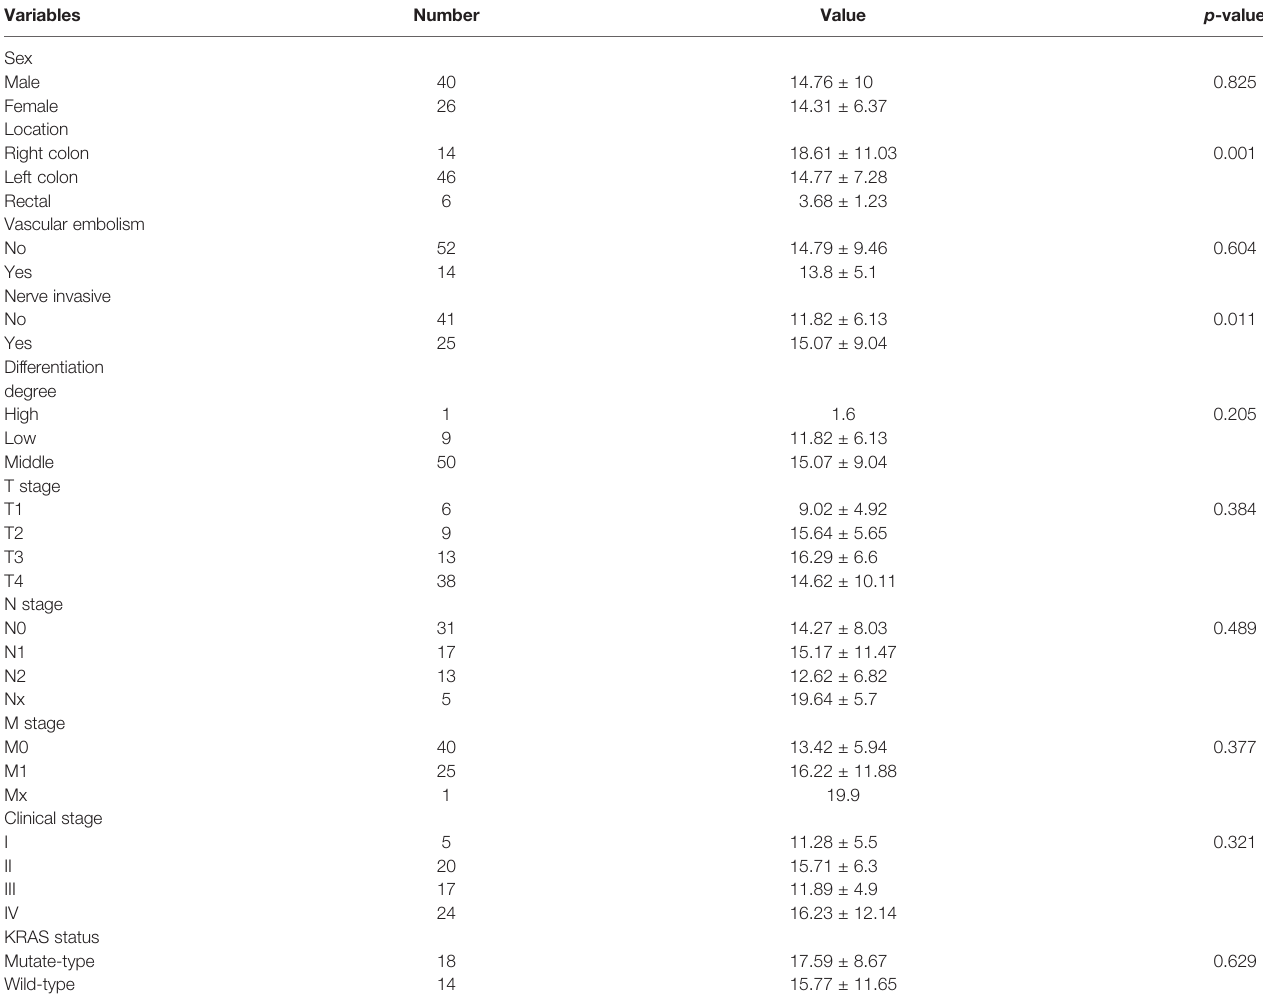
TABLE 2 | Comparison of SUVmax in clinical parameters of CRC